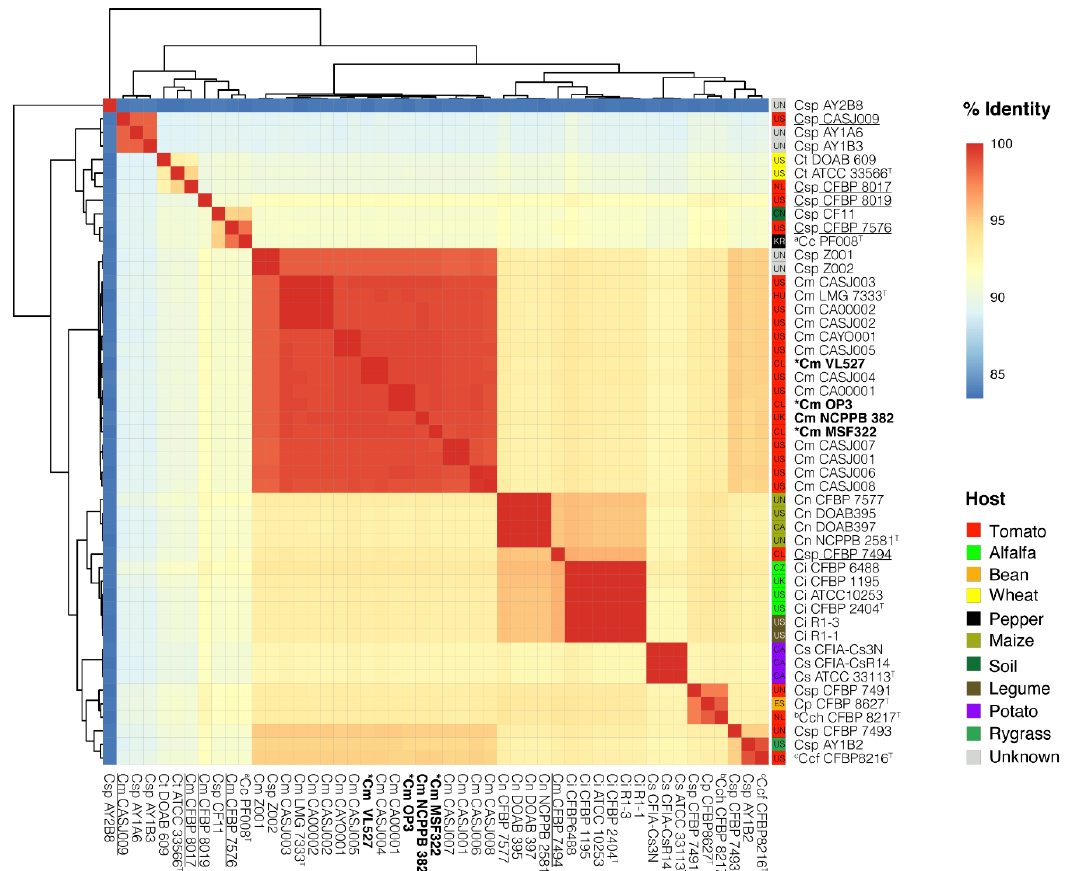
Figure 4. Genome–genome comparisons of representative strains of Clavibacter species, including the Chilean C . michiganensis subsp. michiganensis strains, VL527, MSF322 and OP3. Clustering based on ANIm analysis of 49 strains listed as C. michiganensis is shown (left). Chilean C . michiganensis subsp. michiganensis strains VL527, MSF322, and OP3 (bold, asterisk) are grouped within the main C. michiganensis cluster, together with the reference C . michiganensis subsp. michiganensis strain NCPPB 382 (bold). Strains of C . michiganensis subsp. michiganensis (Cm), C . capsici ( a Cc), C. michiganensis subsp. californiensis ( b Ccf), C. michiganensis subsp. chilensis ( c Cch), C. michiganensis subsp. phaseoli (Cp), C . insidiosus (Ci), C . nebraskensis (Cn), C . sepedonicus (Cs), C. tessellarius (Ct) species, endophytic strains (underlined) and strains of Clavibacter sp. (Csp), i.e., with no designated subspecies were included in the analysis. Isolation sources of strains are indicated (right) and corresponding countries of origin are indicated before each strain name: Canada (CA), Chile (CL), China (CN), Czech Republic (CZ), Hungary (HU), South Korea (KR), Spain (ES), the Netherlands (NL), United Kingdom (UK), United States (US), and of unknown origin (UN). ANIm similarities are shown in Table